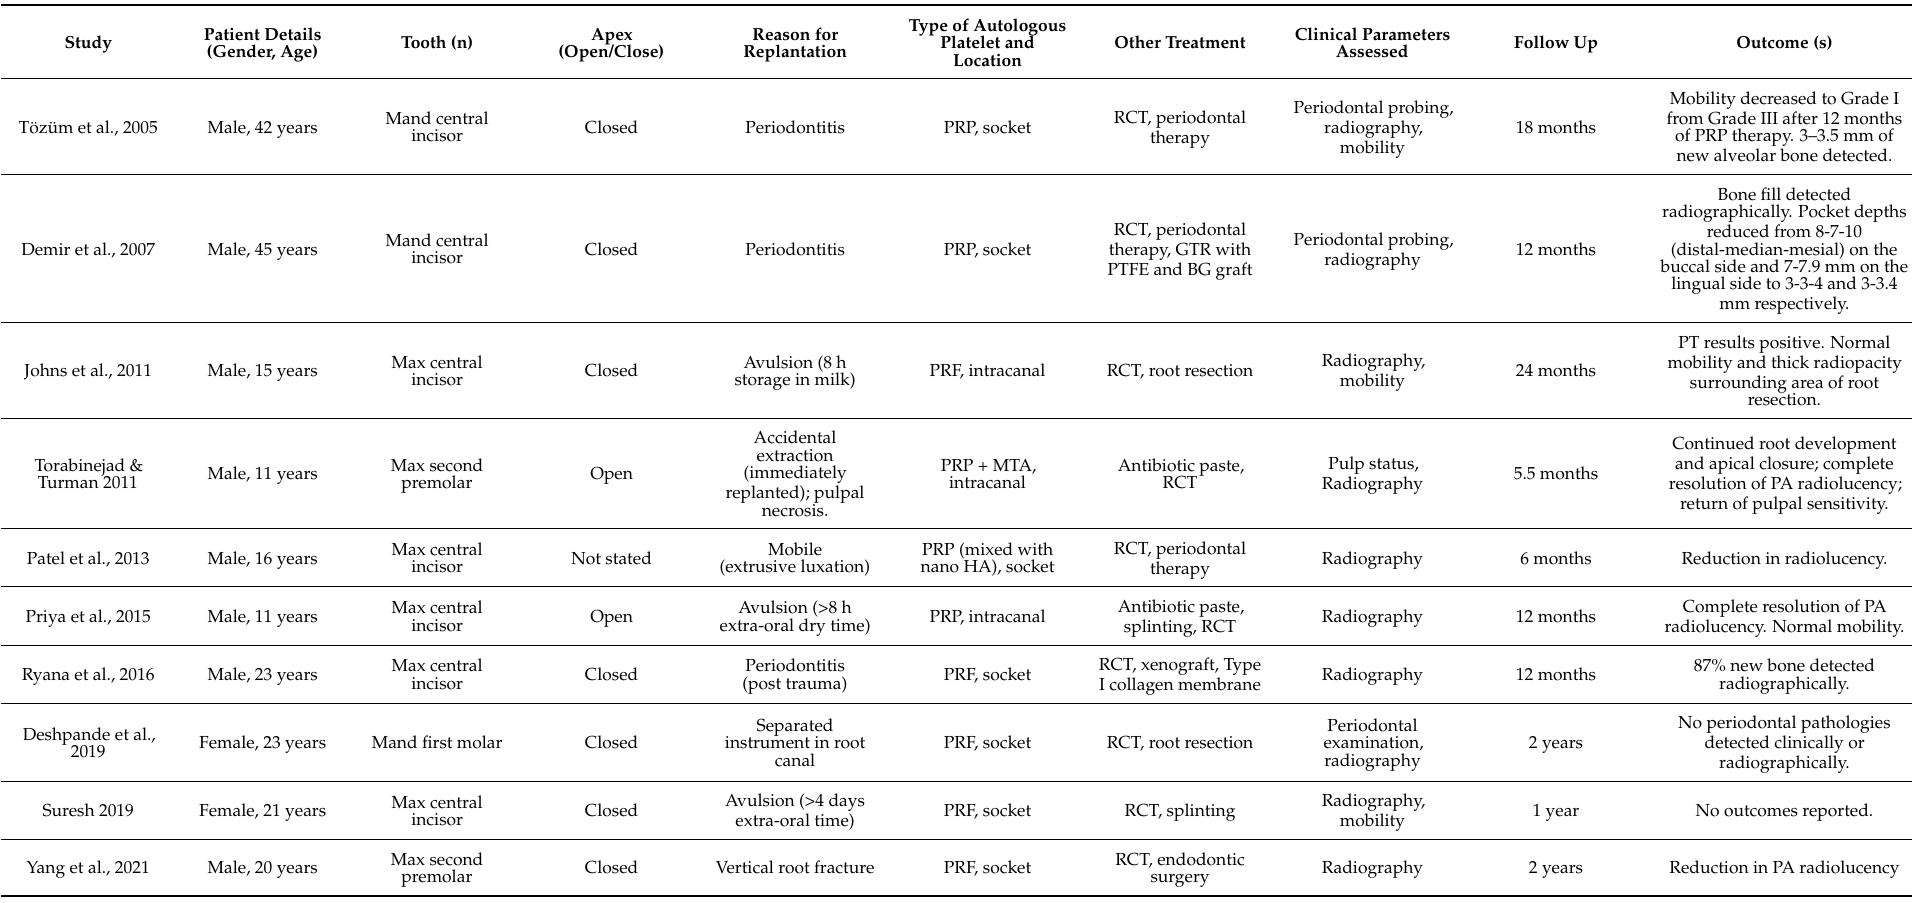
Table 1. General characteristics and outcomes of the case reports describing the use of autologous platelet therapy to improve the outcomes of tooth